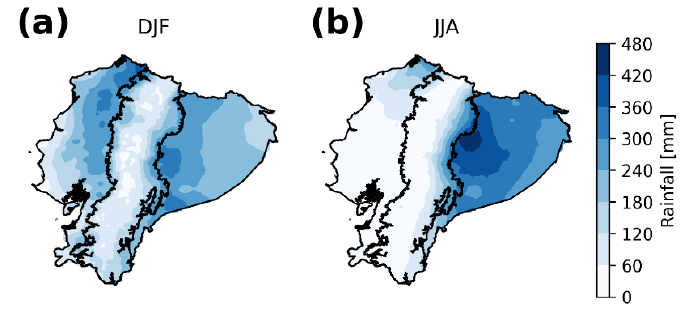
Figure 3. Monthly mean rainfall in ( a ) the austral summer (DJF) and ( b ) winter (JJA) from 1981 to 2016, based on CHIRPS data.